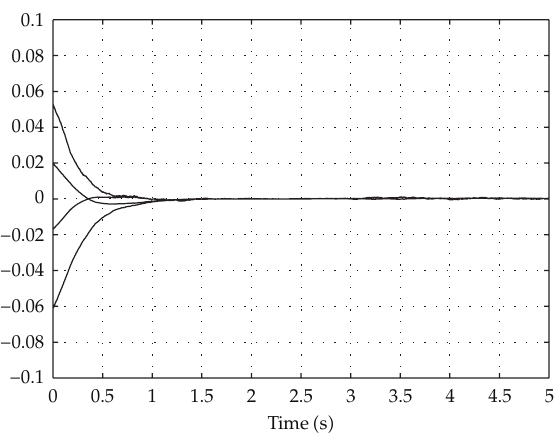
Figure 3: Elements of the weight matrix W (cid:2) t (cid:3)